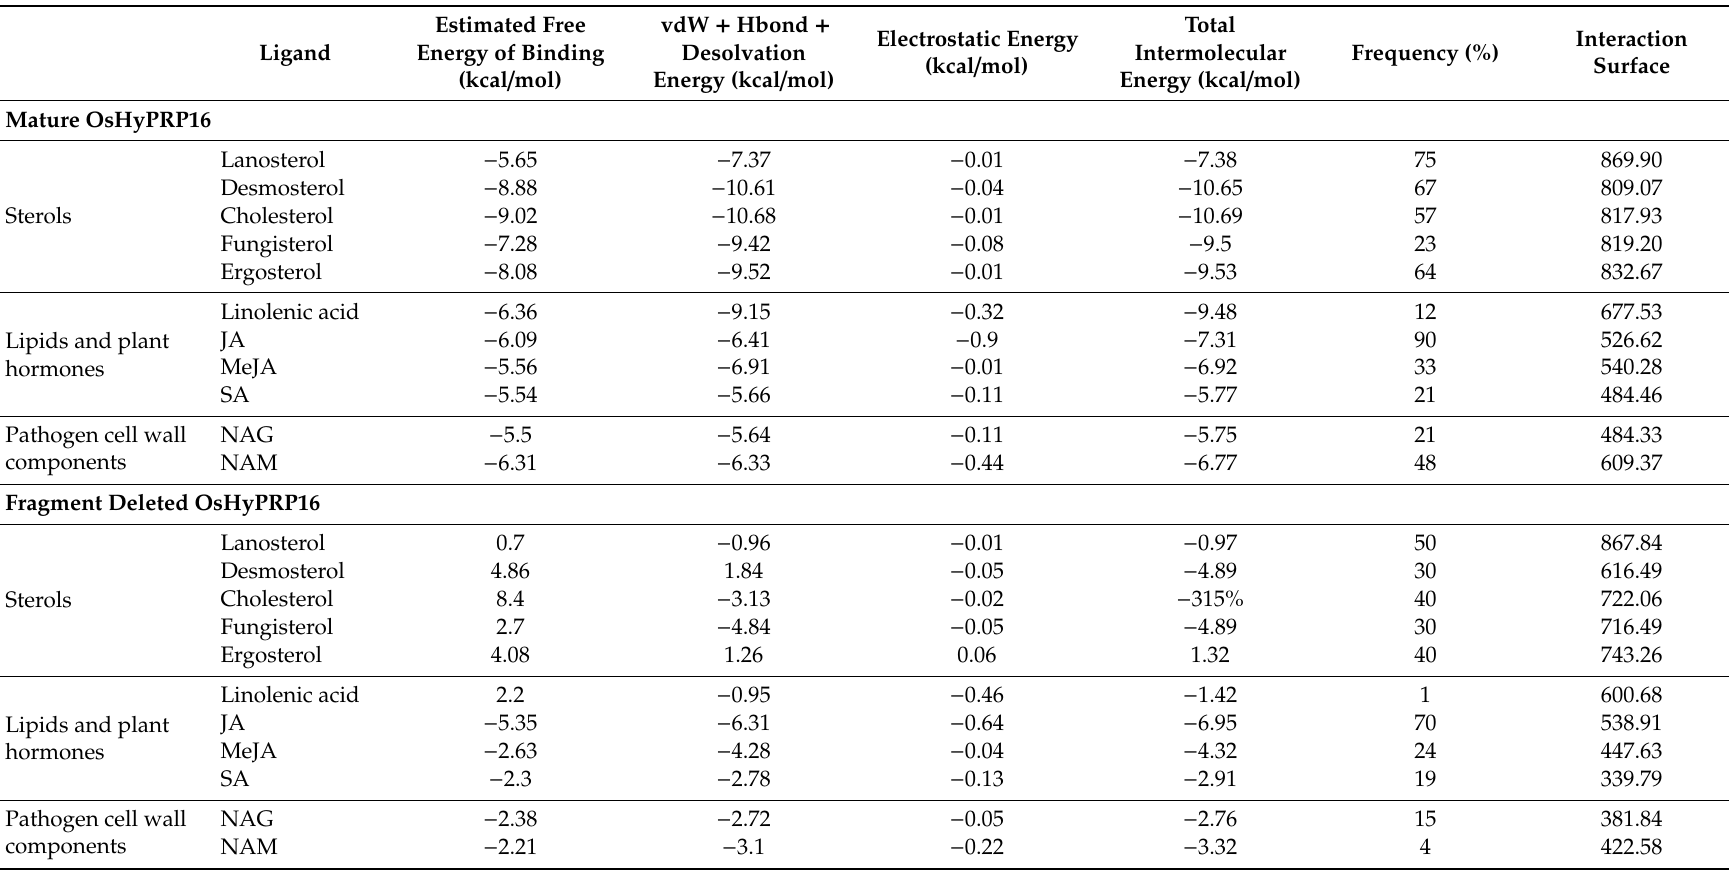
Table 2. The predicted molecular docking energy level and other features for the interaction of various ligands with mature and fragment deleted OsHyPRP16. Estimated Free Ligand Mature